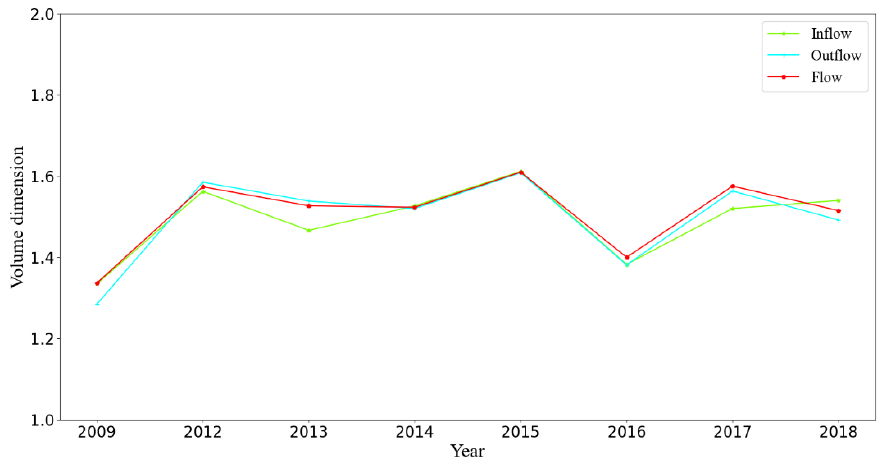
Figure 5. Fitting plots of station dimension for different years.